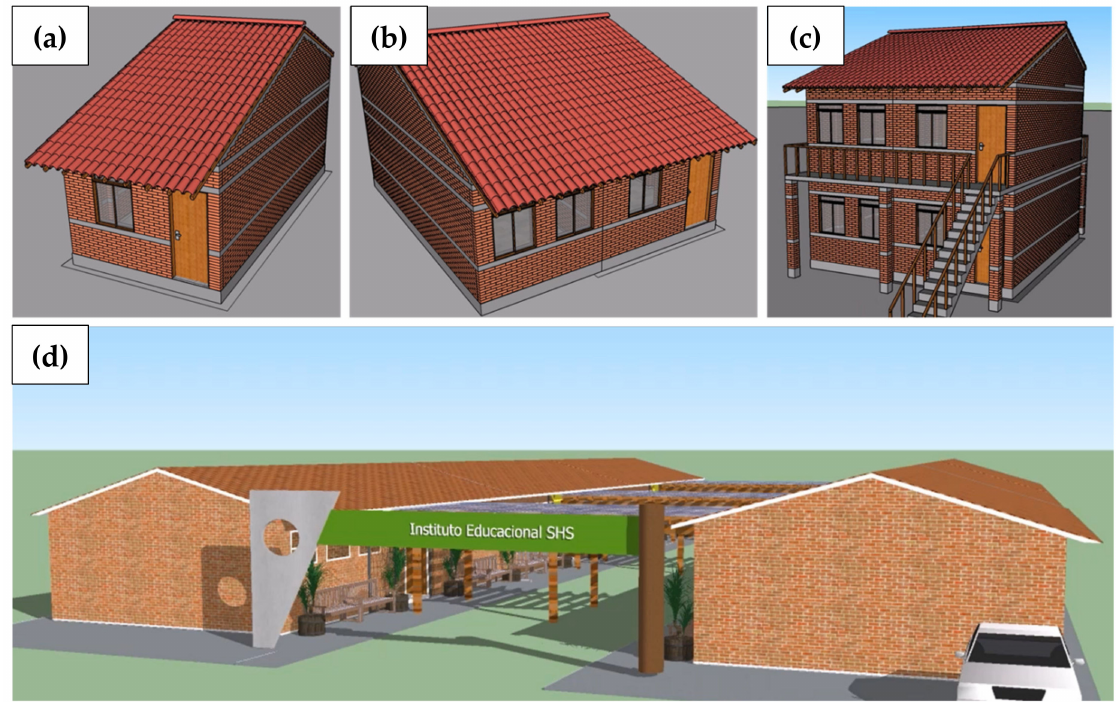
Figure 2. Models for situations with usual horizontal loads. ( a ) Embryo 1; ( b ) Embryo 2; ( c ) Embryo 4; ( d ) School